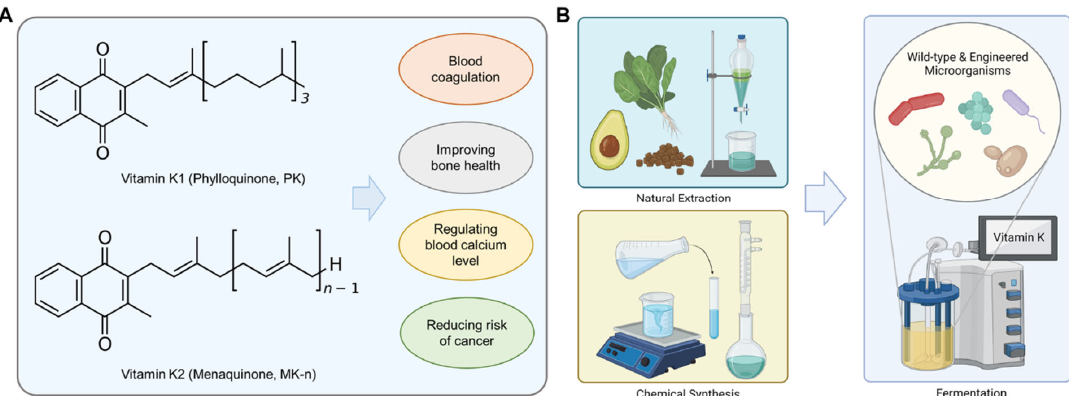
Figure 1. Vitamin K production using microorganisms. ( A ) Chemical structures of vitamin K and its biological functions, and ( B ) Methods of vitamin K production including natural extraction, chemical synthesis, and fermentation.